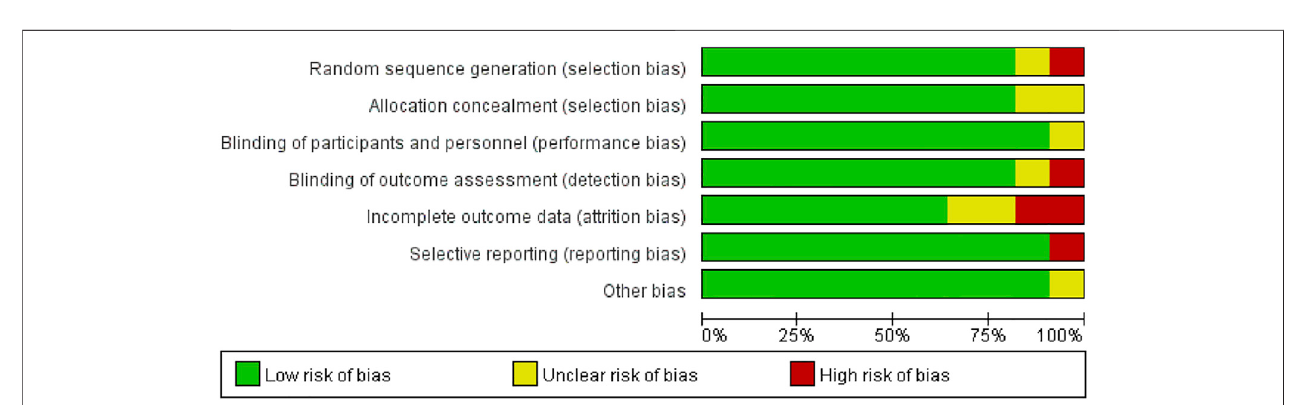
FIGURE 1 | PRISMA fl ow chart of study selection.